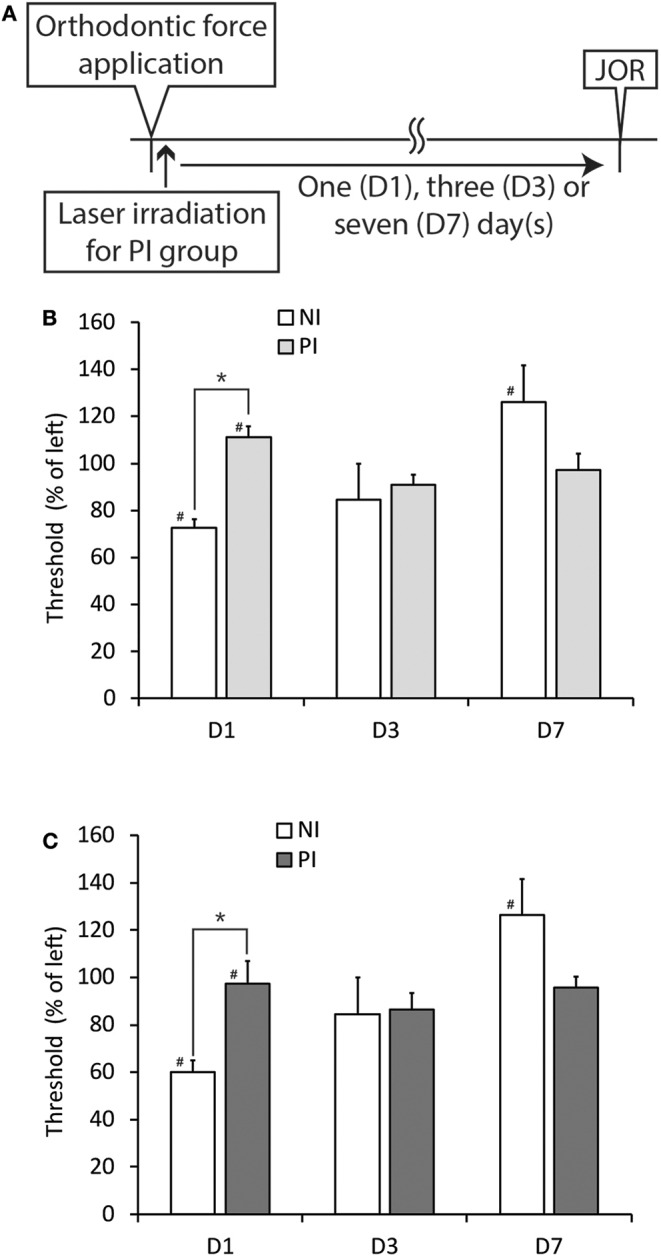
Effects of CO2 or diode laser irradiation immediately after the application of orthodontic force (preirradiation) on the development of orthodontic treatment-induced excitation of the jaw-opening reflex. (A) Experimental procedure for the application of orthodontic force, laser irradiation and the evaluation of jaw-opening reflex excitability. (B) Thirty seconds of CO2 laser irradiation significantly increased the right-side threshold for inducing the jaw-opening reflex on D1, but this effect was not observed at three or seven days after PI (D3 and D7). (C) Thirty seconds of diode laser irradiation significantly increased the right-side threshold for inducing the jaw-opening reflex on D1, but this effect was not observed at 3 or 7 days after PI (D3 and D7). NI, non-irradiation; PI, preirradiation; JOR, evaluation of jaw-opening reflex excitability. Student's t-test, *p < 0.05: NI vs. PI. Paired t-test, #p < 0.05: left vs. right in the same group.